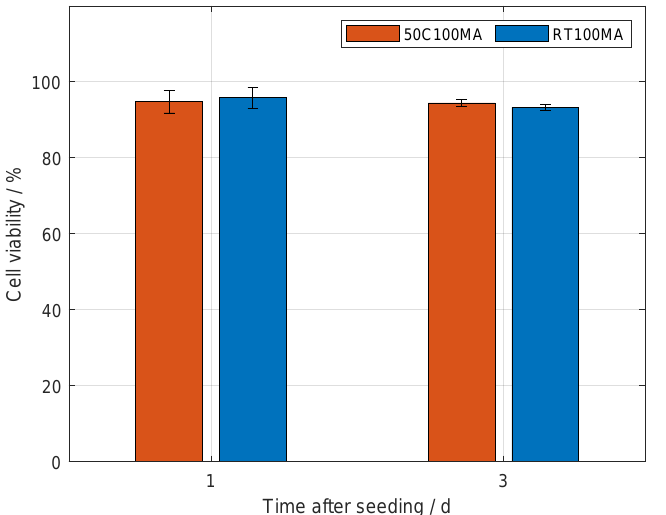
Figure 6. Cell viability of NIH 3T3 fibroblasts on gelatin methacryloyl (GelMA) coated well plates. GelMA produced similar to the method of Shirahama [18] at 50 °C (50C100MA) was used as a control in comparison with GelMA produced by the novel approach presented in this study, i.e., at room temperature (RT100MA). The viability of cells seeded onto both hydrogels samples did not differ significantly after one and three